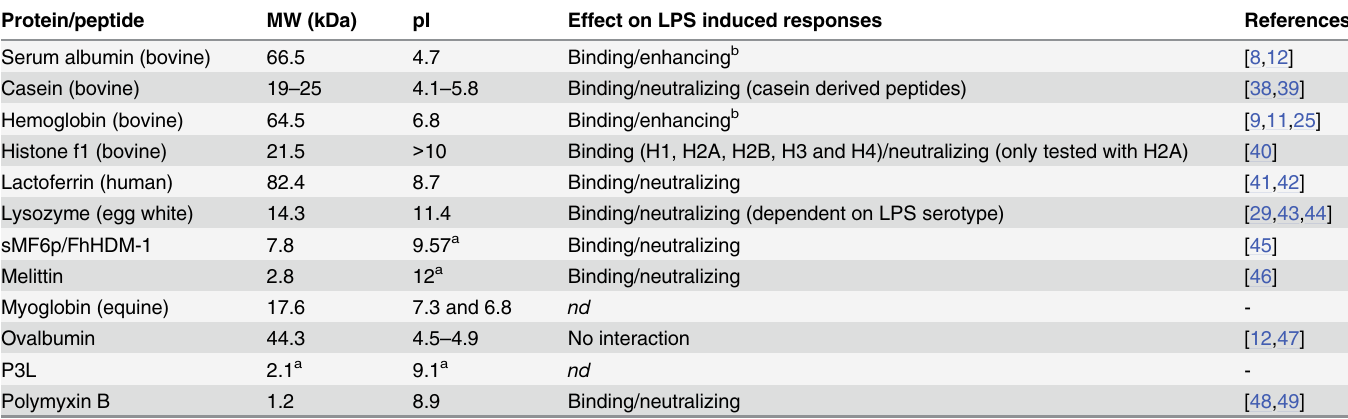
Table 1. LPS-binding properties of proteins and peptides investigated in the